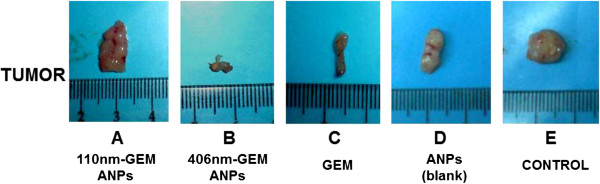
Neoplastic mass comparison among different treatment groups. After being excised from the PANC-1-induced nude mice tumor model following their scarification at the end of the experiments. A 110-nm GEM-ANPs, B 406-nm- GEM-ANPs, C gemcitabine, D ANPs, and E control.